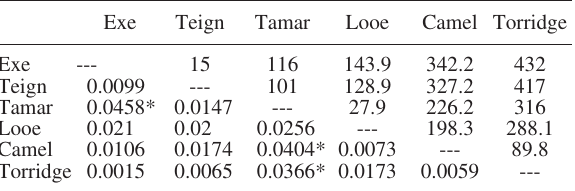
Table 2. – Genetic differentiation among Carcinus maenas popula- tions. F values are below diagonal, and geographic distances (km) ST among populations are above diagonal. * p <0.05: significance of F after sequential Bonferroni correction. ST